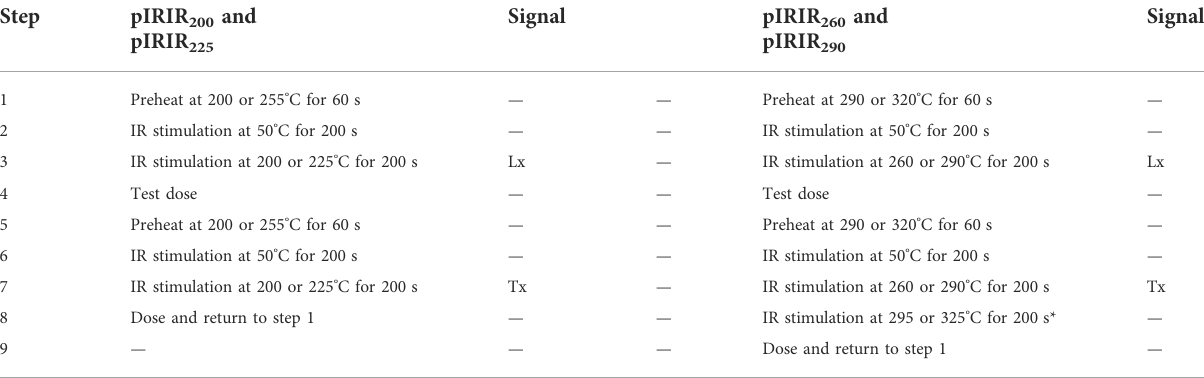
TABLE 3 Summary of the pIRIR single-aliquot regenerative dose protocol used in this study.